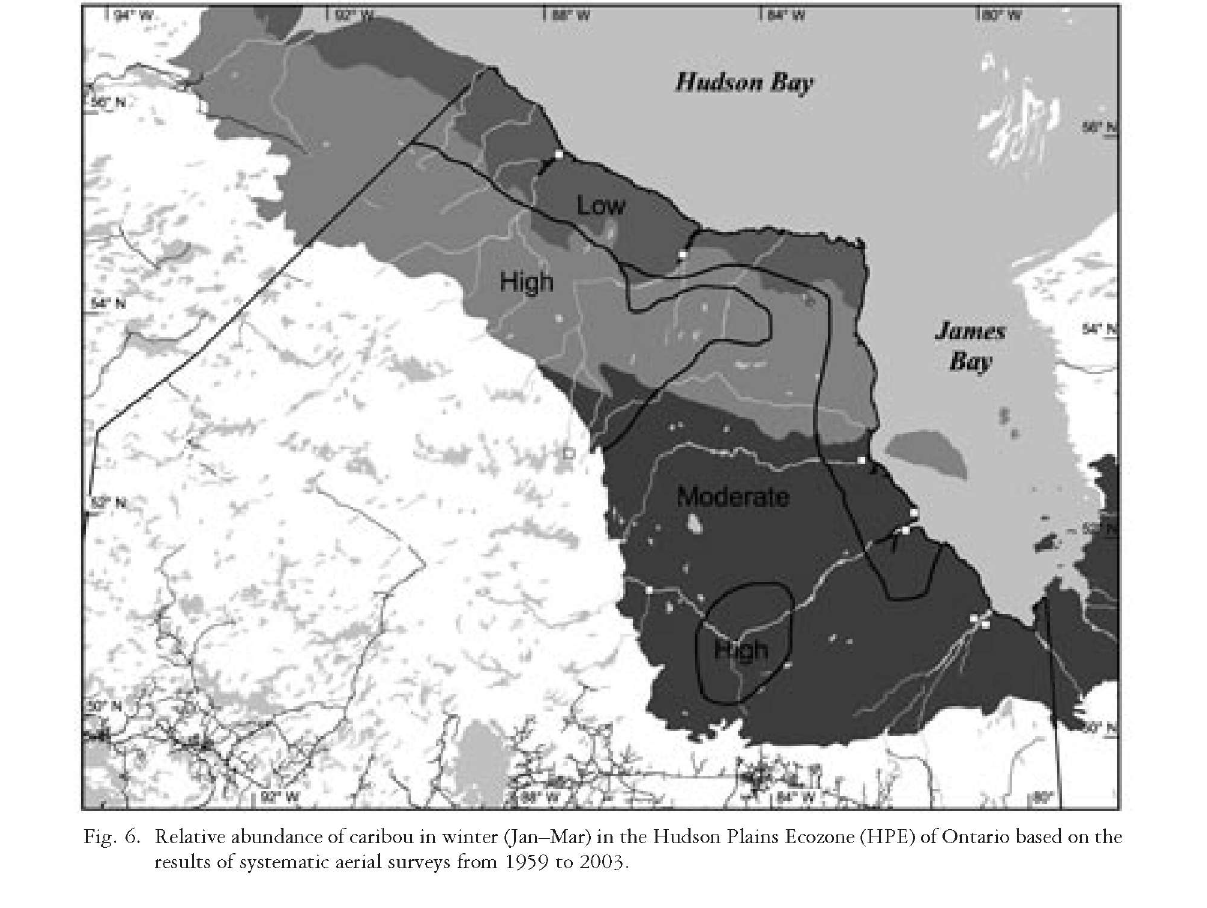
Fig. 6. Relative abundance of caribou in winter (Jan—Mar) in the Hudson Plains Ecozone (HPE) of Ontario based on the results of systematic aerial surveys from 1959 to